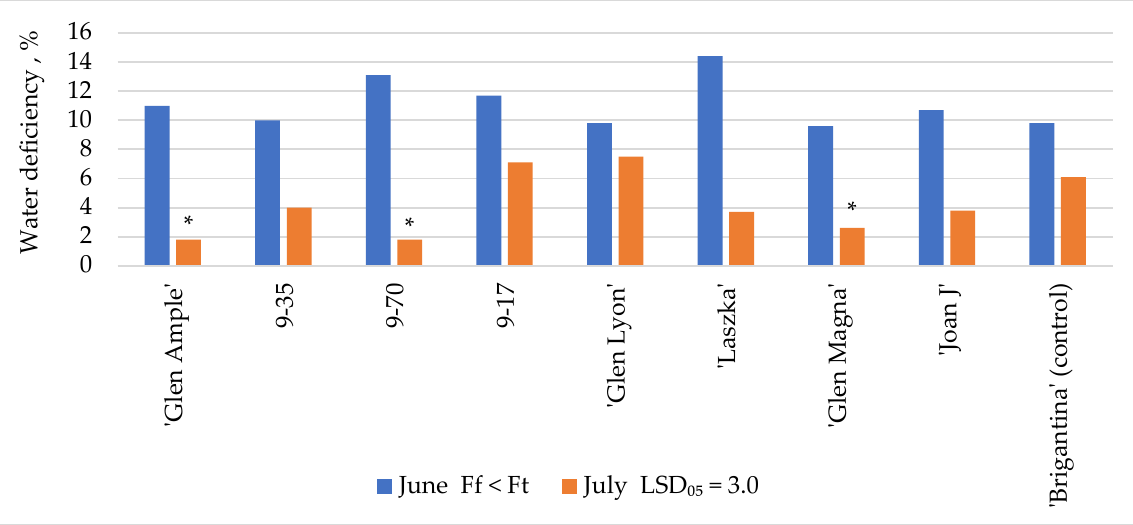
Figure 3. Water deficiency of raspberry leaves in the field, % (2019–2021). *—significant differences at the 5% significance level.